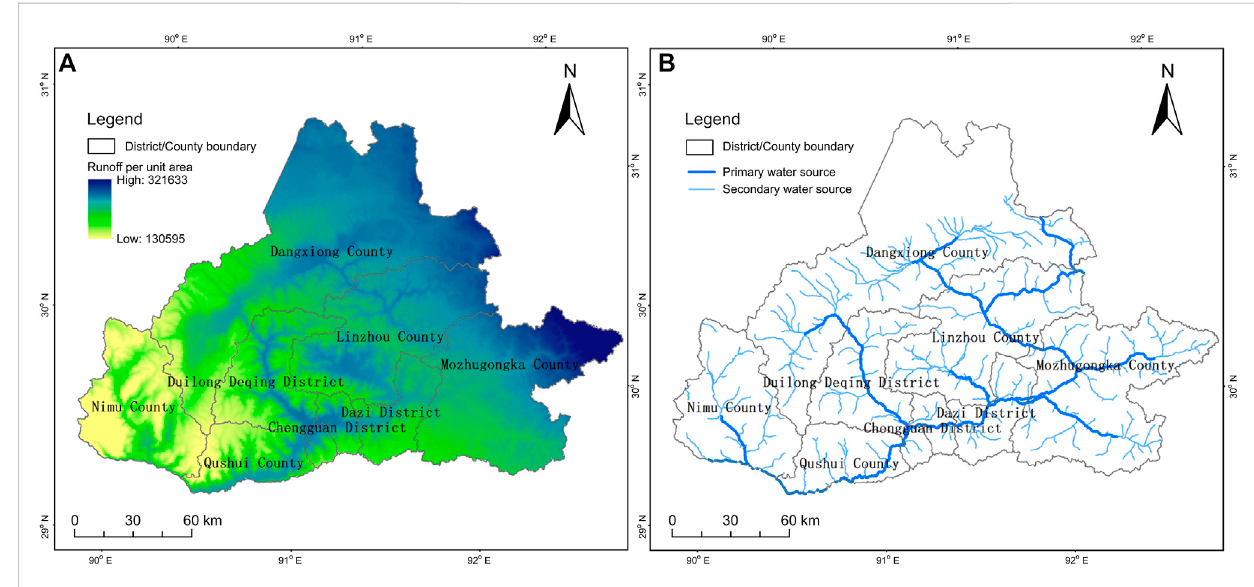
Figure 5B. The primary water source referred to the water source